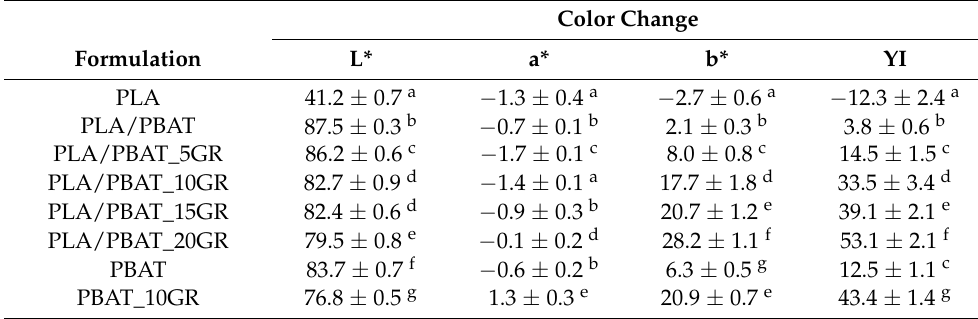
Table 2. Color change of the studied